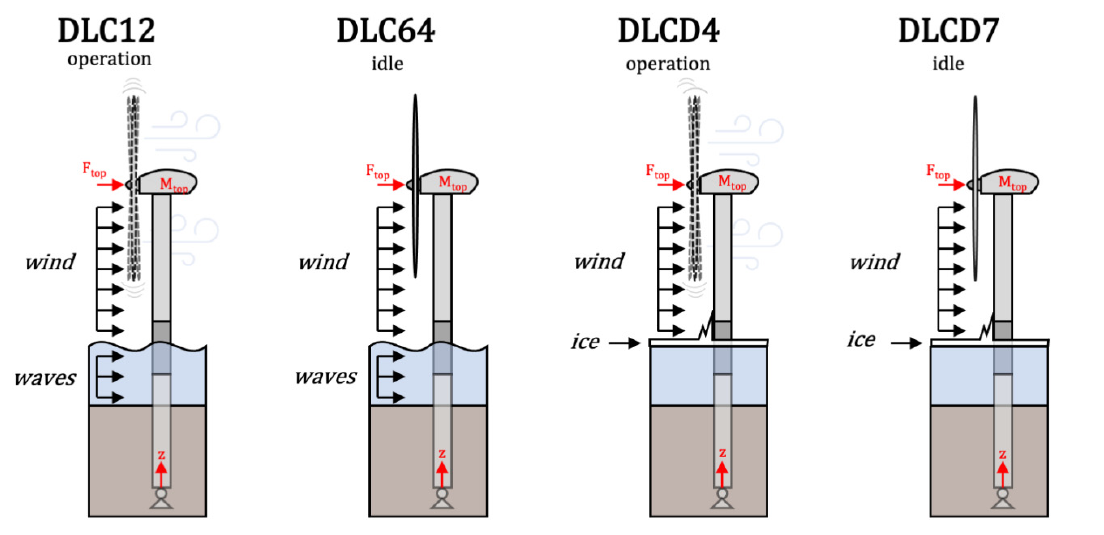
Figure 1. The four main load case scenarios of an offshore wind turbine structure.